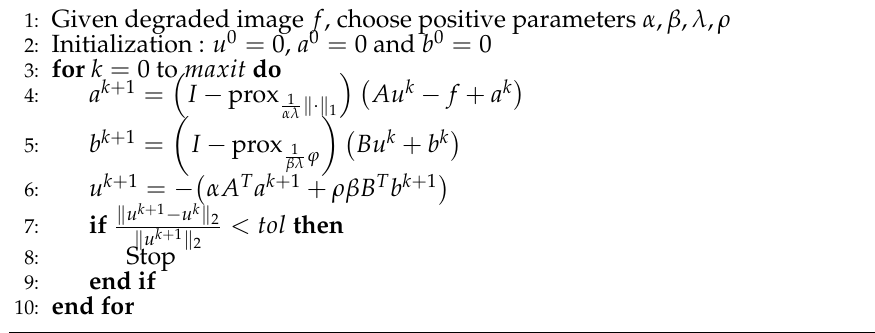
Algorithm 1 Fixed-point method for the TVL1 problem Equation (4)